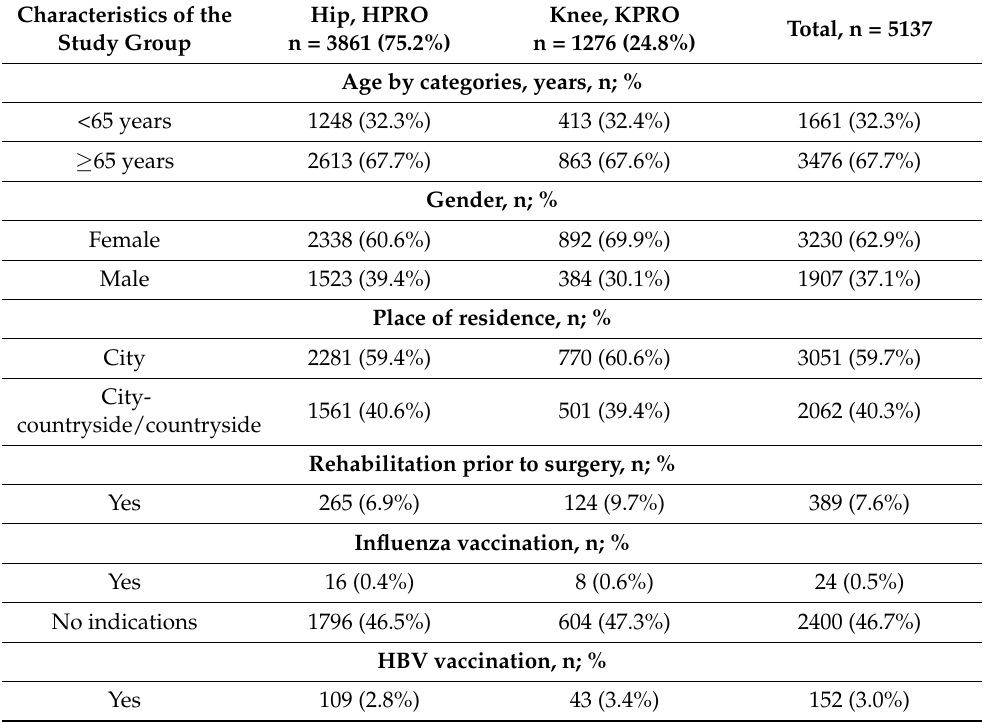
Table 2. Characteristics of the population for revision